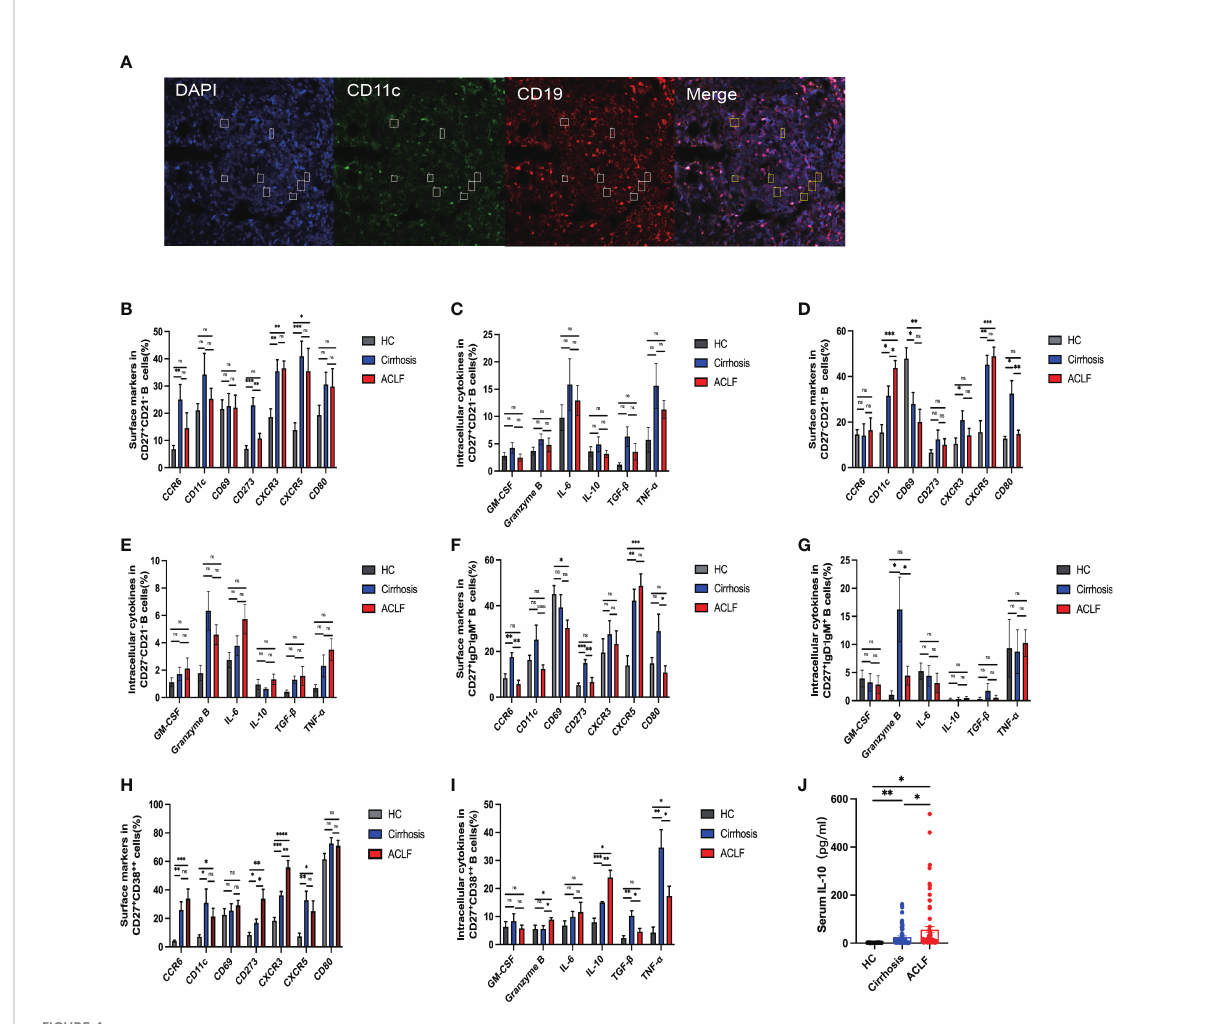
FIGURE 4 The phenotypic and functional analysis of B-cell subsets in ACLF, cirrhosis, and HC. (A) Representative confocal images of CD11c + CD19 + cells using human liver biopsies from patients with ACLF. (B, C) The expression of surface markers and intracellular cytokines on CD27 + CD21 − CD19 + B cells from the liver of ACLF, cirrhosis, and HC (HC, n = 4; cirrhosis, n = 6; ACLF, n = 7). (D, E) The expression of surface markers and intracellular cytokines on CD27 − CD21 − CD19 + B cells from the liver of ACLF, cirrhosis, and HC (HC, n = 4; cirrhosis, n = 6; ACLF, n = 7). (F, G) The expression of surface markers and intracellular cytokines on CD27 + IgD − IgM + CD19 + B cells from the liver of ACLF, cirrhosis, and HC (HC, n = 4; cirrhosis, n = 6; ACLF, n = 7). (H, I) The expression of surface markers and intracellular cytokines on CD27 + CD38 ++ CD19 + B cells from the liver of ACLF, cirrhosis, and HC (HC, n = 4; cirrhosis, n = 6; ACLF, n = 7). (J) The concentration of cytokines IL-10 in the serums of ACLF, cirrhosis, and HC using cytometric bead array (CBA) (HC, n = 24; cirrhosis, n = 67; ACLF, n = 74). *p < 0.05, **p < 0.01, ***p < 0.001, and ****p < 0.0001; ns, not signi fi